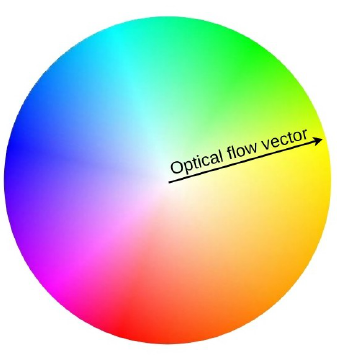
Figure 15. Color wheel that defines the heatmap pixels color.